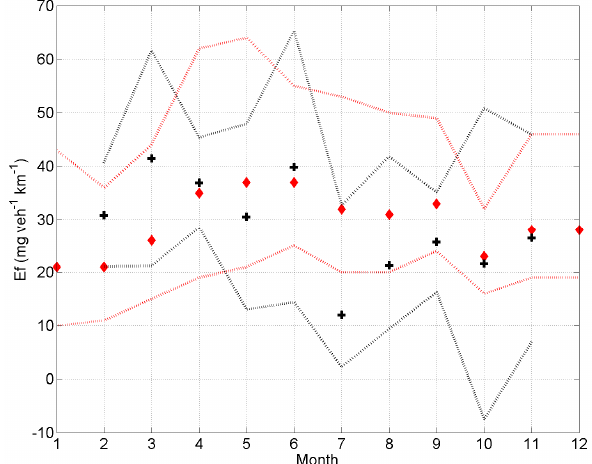
Fig. 5. Monthly median emission factors (red, triangle) street Fig 5: Monthly median emission factors (red, triangle) street canyon, using the NO x method and canyon, using the NO x method and (black, plus) tower using the (black, plus) tower using the eddy covariance method. The red dashed lines are the 25, 75 eddy covariance method. The red dashed lines are the 25, 75 per- centiles. The black dashed lines are the variability using the 95 percentiles. The black dashed lines are the variability using the 95 confidence interval of the confidence interval of the linear fit as shown in Fig. linear fit as shown in Fig 4.